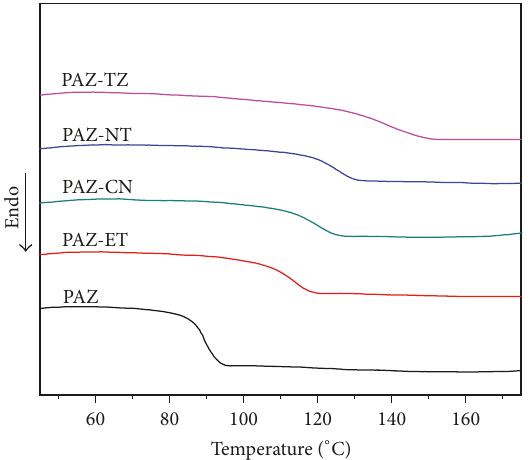
Figure 3: DSC curves of the polymers obtained from the second heating scan.